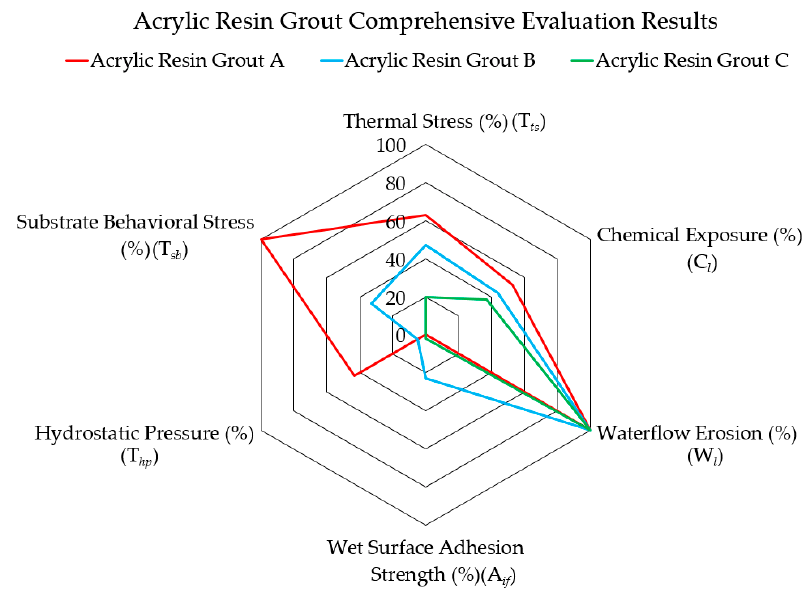
Figure 13. The physical property changes of the acrylic-resin grout-injection material.